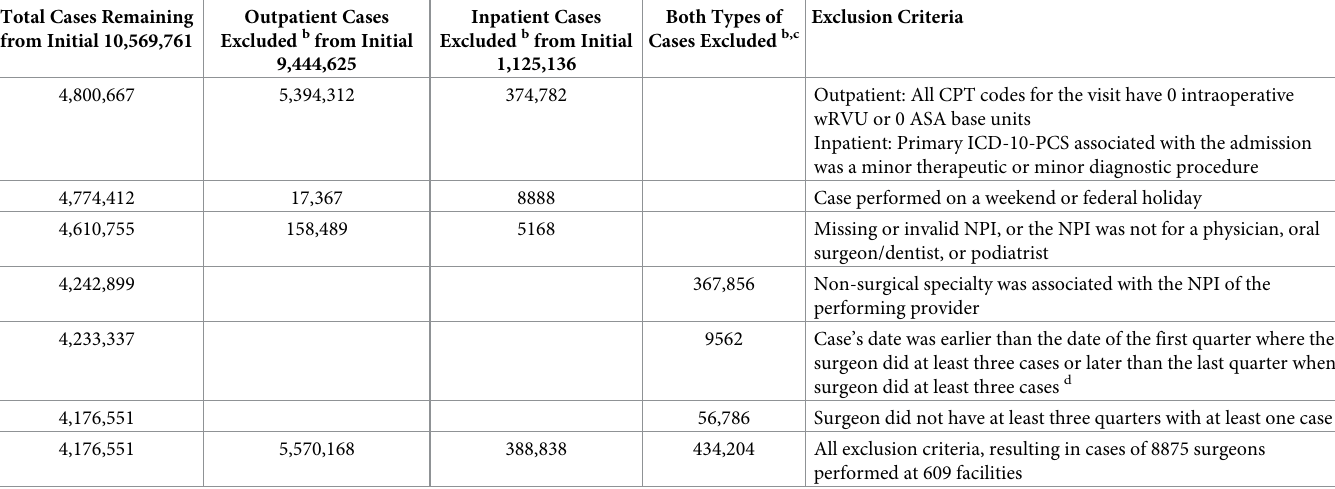
Table 1. Flow diagram of elective case a exclusions from the 287 hospitals and 440 ambulatory surgery centers in Florida, 2017–2019. Total Cases Remaining from Initial